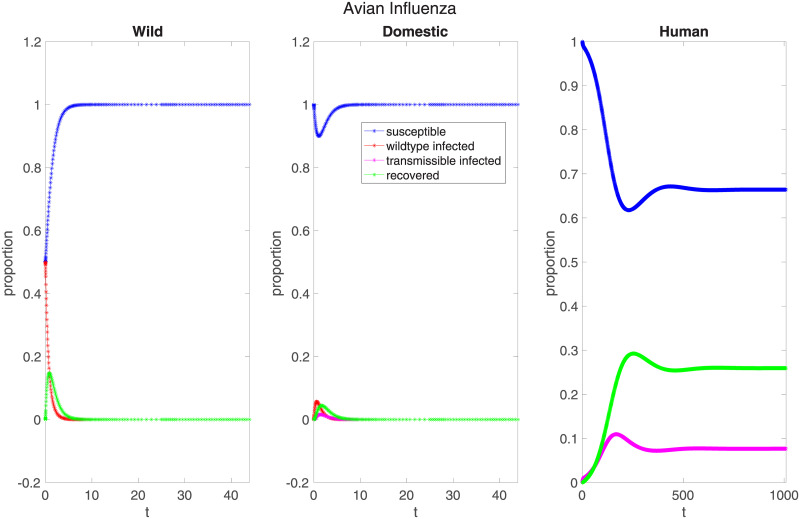
A simulation of low-pathogenic avian influenza mutating to high-pathogenic avian influenza.Parameters are as shown in Table 5. While the epidemic dies out in the animal species, its R0 is 2.0871, allowing an epidemic to persist in humans.